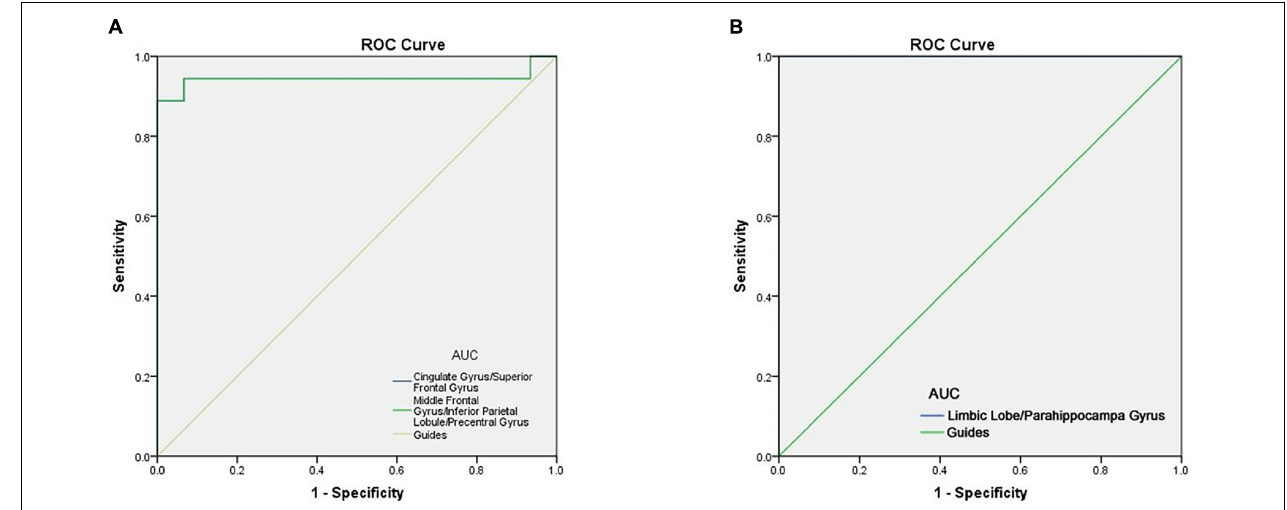
FIGURE 4 | ROC curve analysis of the mean ReHo values for altered brain regions. (A) The area under the ROC curve were 0.944 ( p < 0.0001; 95% CI: 0.845–1.000), for Cingulate Gyrus/Superior Frontal Gyrus, Middle Frontal Gyrus/Inferior Parietal Lobule/Precentral Gyrus 0.944 ( p < 0.0001; 95% CI: 0.845–1.000).